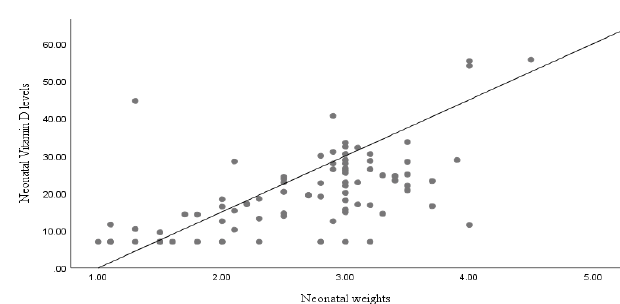
Figure 4: Correlation between neonatal Vitamin D levels and neonatal weights (r = 0.320, p = 0.002 ((significant)). Neonatal weights were positively correlated with maternal Vitamin D levels (Figure 5).